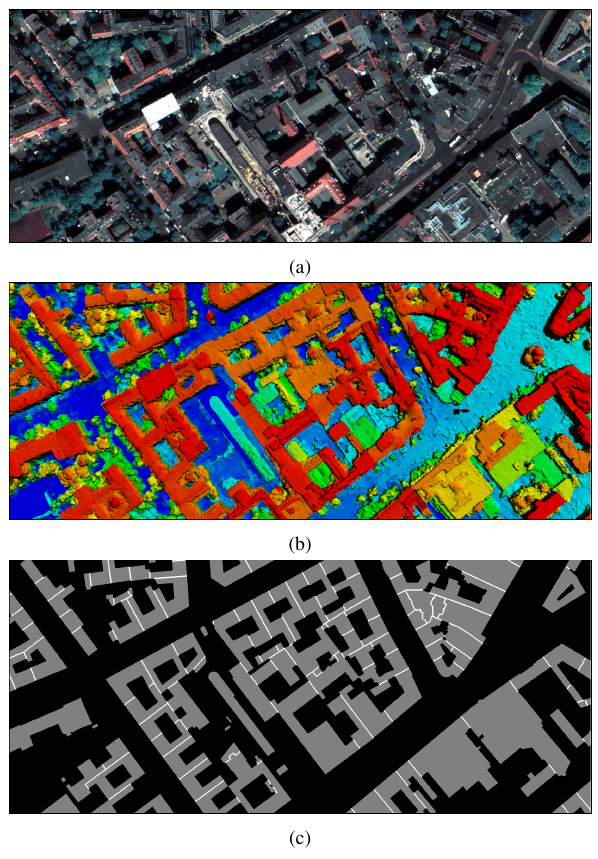
Figure 3. A sample area of the dataset, consisting of (a) RGB, (b) DSM and (c) the three-class ground